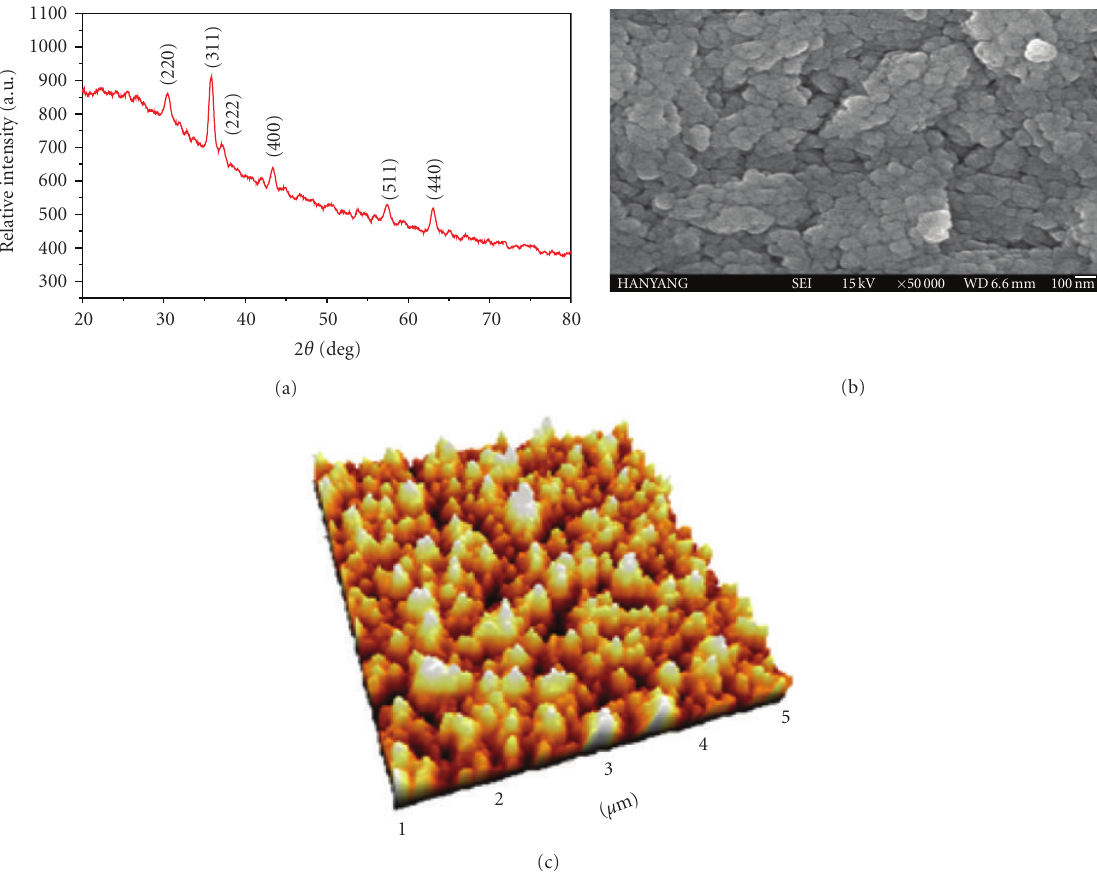
Figure 1: (a) Normalized XRD pattern, (b) SEM, and (c) 3D AFM image confirming the structural identification with spherical crystallites evolution of cobalt